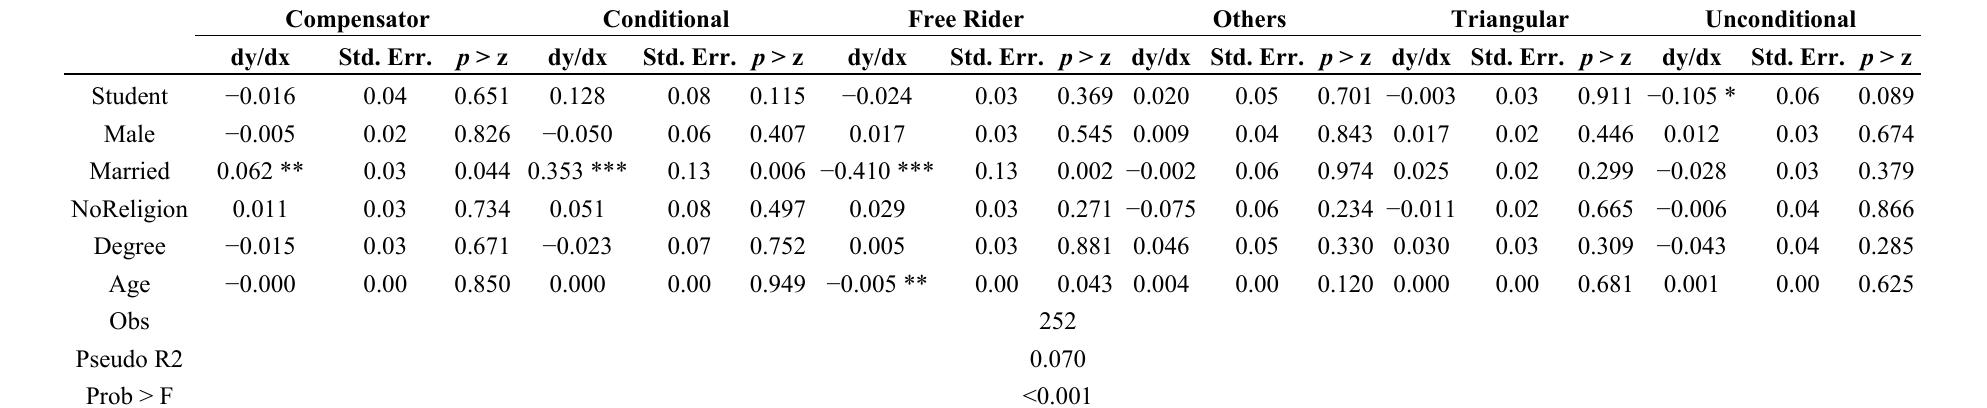
Table A9. Multinomial logit (Strategy